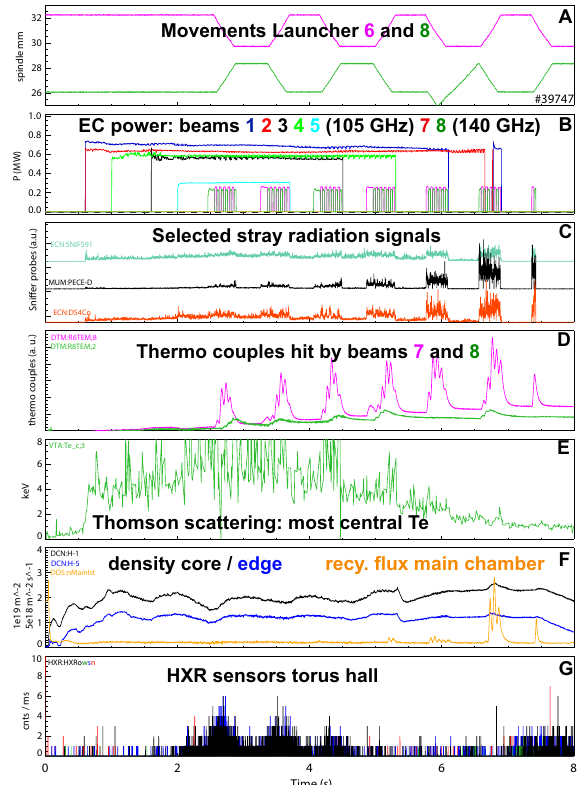
Figure 4. AUG #39747, I p : 800 kA, B t : -1.6 T. To ensure plasma initiation and to avoid locked-modes in the ramp-up phase the plasma was started with B t : -1.7 T. The field was changed be- tween 1.4-2.6 s. Otherwise identical control parameters as fig- ure 3, except that beam 6 had to be used with 140 GHz since beam 7 was not available. The 105 GHz heating uses up to 5 beams (4 in fig. 3). As can be seen from box A, there was a mis- take in programming the fifth sweep of launcher 8 in this specific discharge. Consequently, there is no rise of the TC on the respec- tive reflector in box